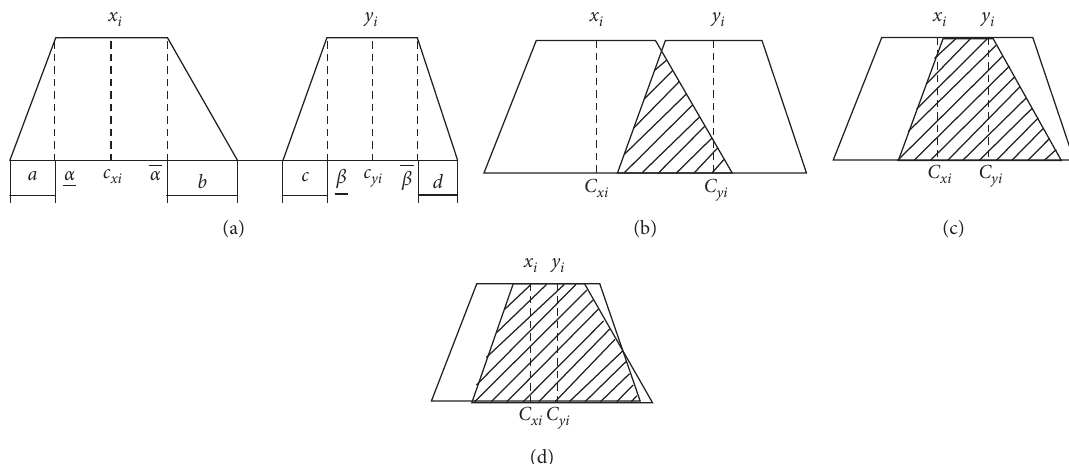
Figure 4: The intersection types between two fuzzy attribute domains x